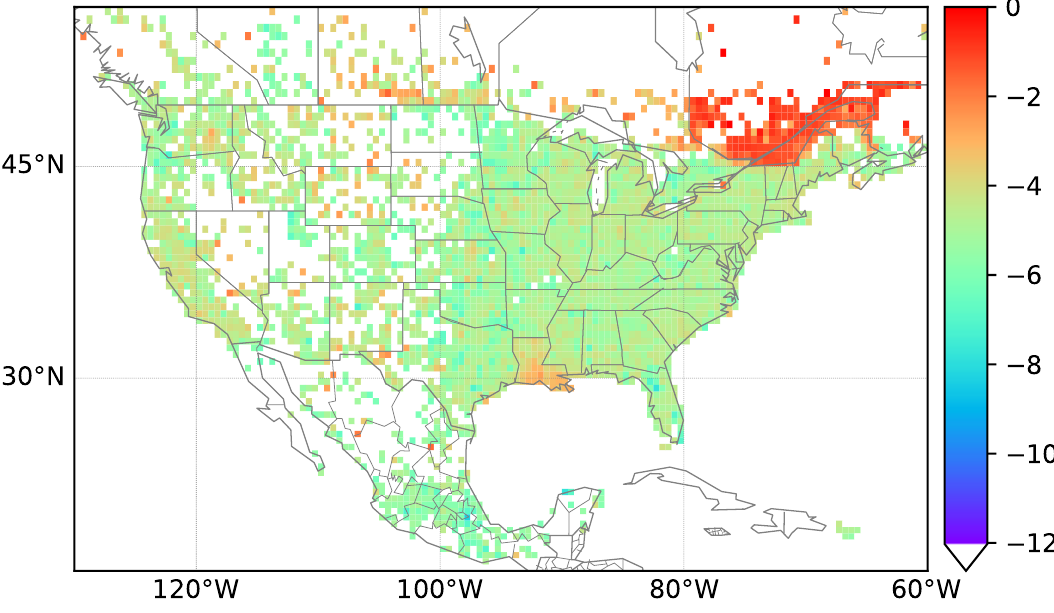
Figure 5. Heatmap of North America showing the density of streets classified as French. Colors indicate the density of streets in this area, thus the logarithmic value of the number of streets normalized by all streets in the cell of the grid.